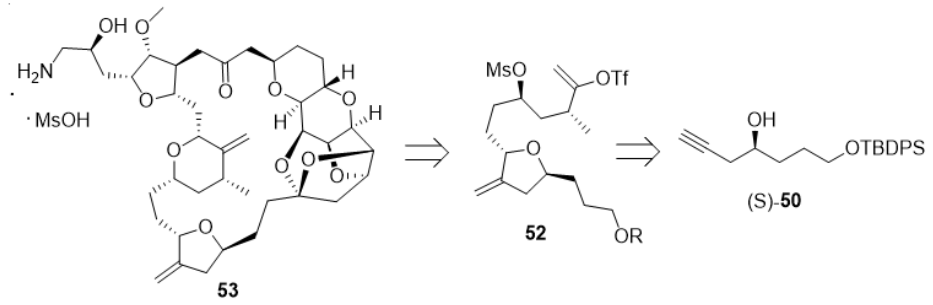
Figure 8. Structure of eribulin mesylate ( 53 ) and its building blocks 52 and (S)- 50 .